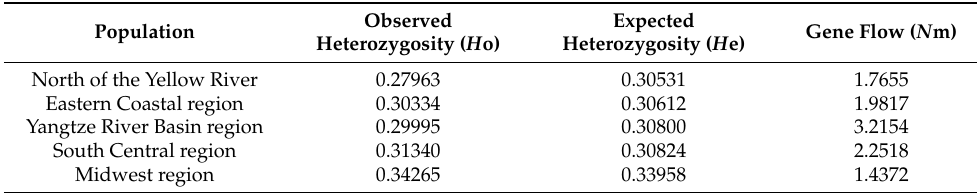
Table 4. Genetic diversity level of five